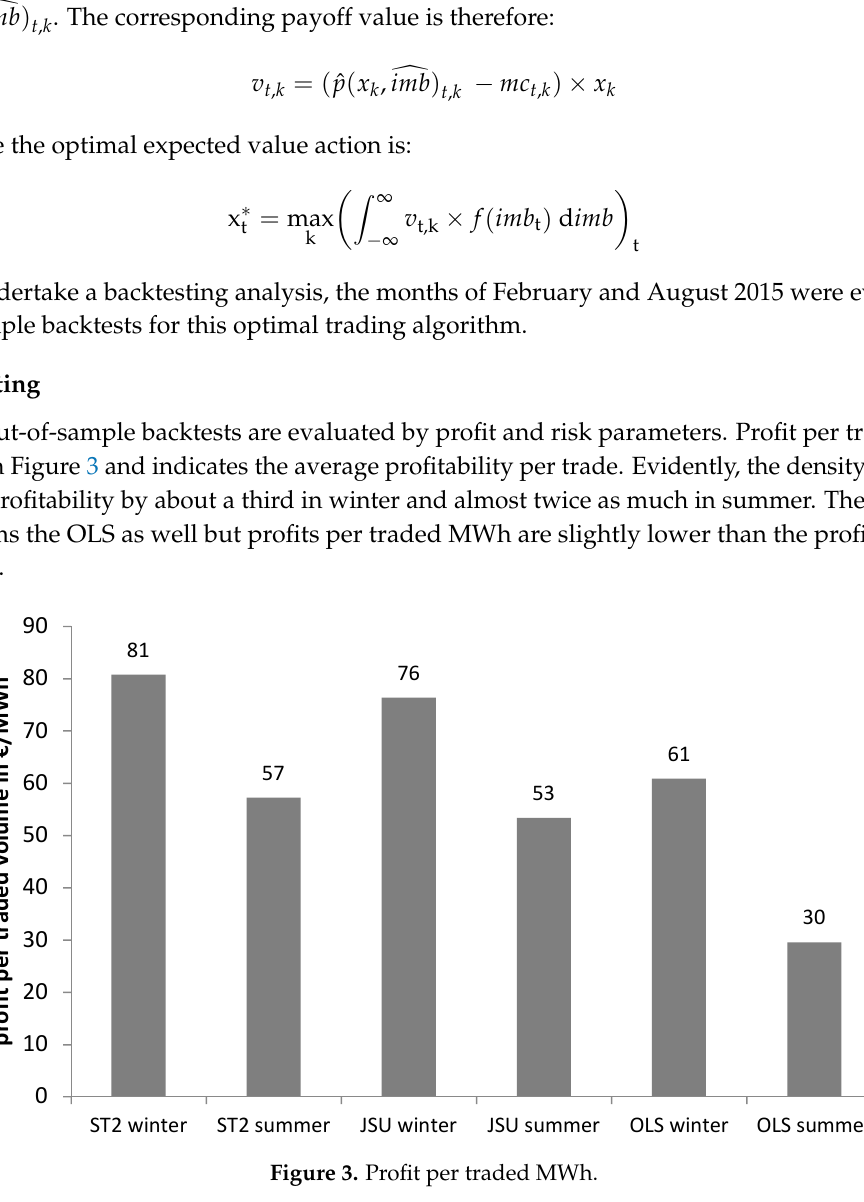
Figure 4. Traded volume.